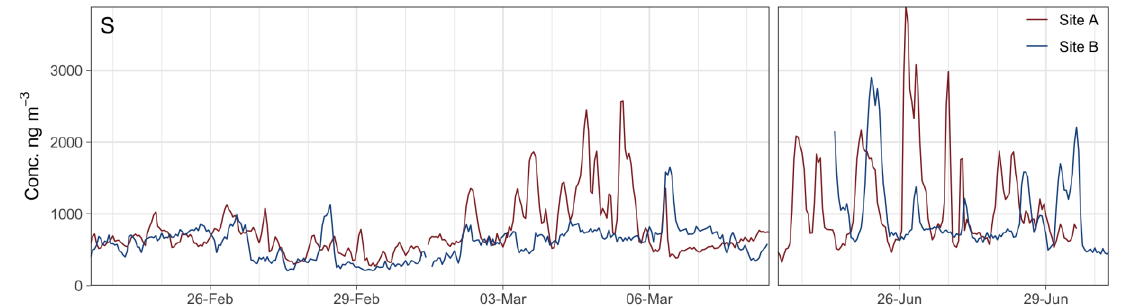
Figure 5. Temporal trends (in ng m − 3 ) of Sulphur (S) measured simultaneously at the two sites in the fine fraction.